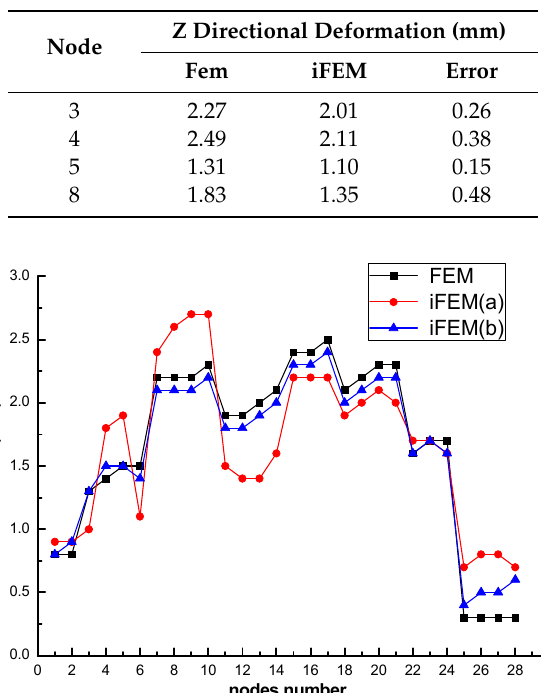
Table 2. Results of the nodes deformation.